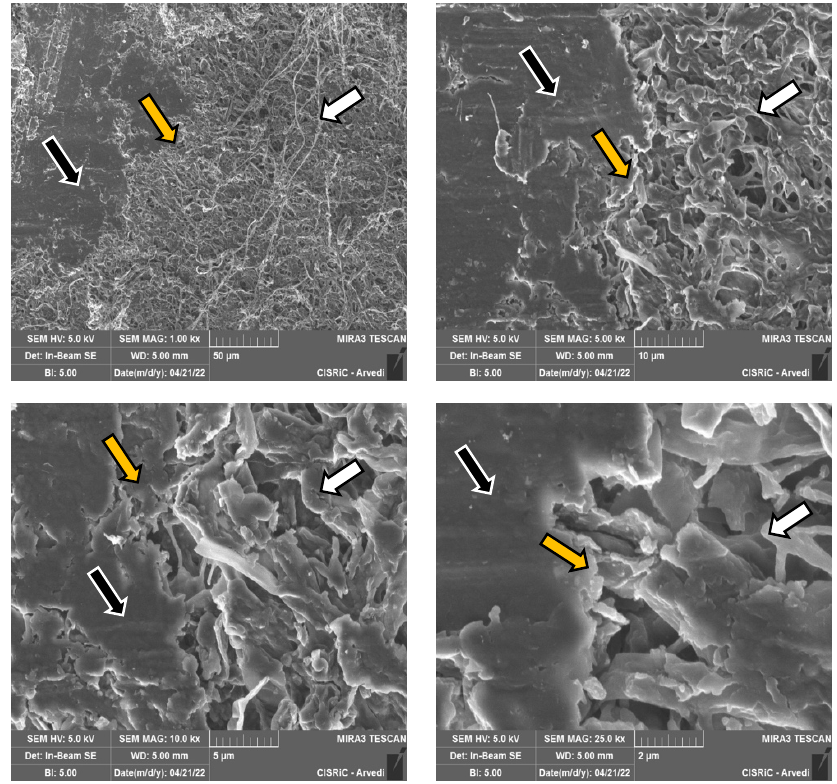
Figure 11. SEM images of colonization and growth on membrane by T. mentagrophytes 10326, in different magnifications. In each image, a membrane portion not yet colonized is visible on the left (black arrows), and the already developed mycelium on the right (white arrows). In the center, there is the point of contact between the fungus and the membrane, which at higher magnifications can be seen to be degraded (yellow arrows).